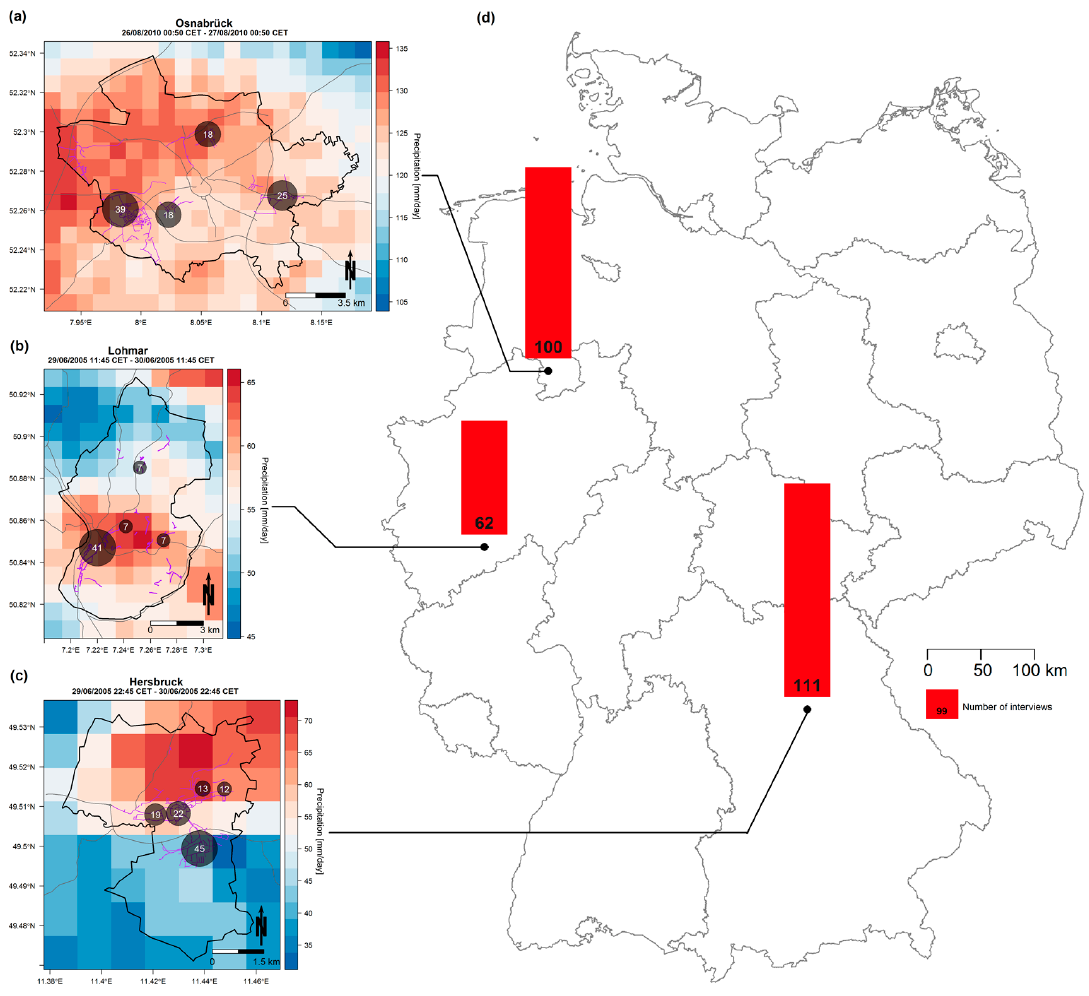
Figure 1. Spatial distribution of rainfall amount (24 h precipitation radar data), affected streets ( purple ) and number per interviews per neighborhood ( grey bubbles) for the study areas ( a ) Osnabrück; ( b ) Lohmar; ( c ) Hersbruck; ( d ) location of the study areas and number of completed interviews per study area.